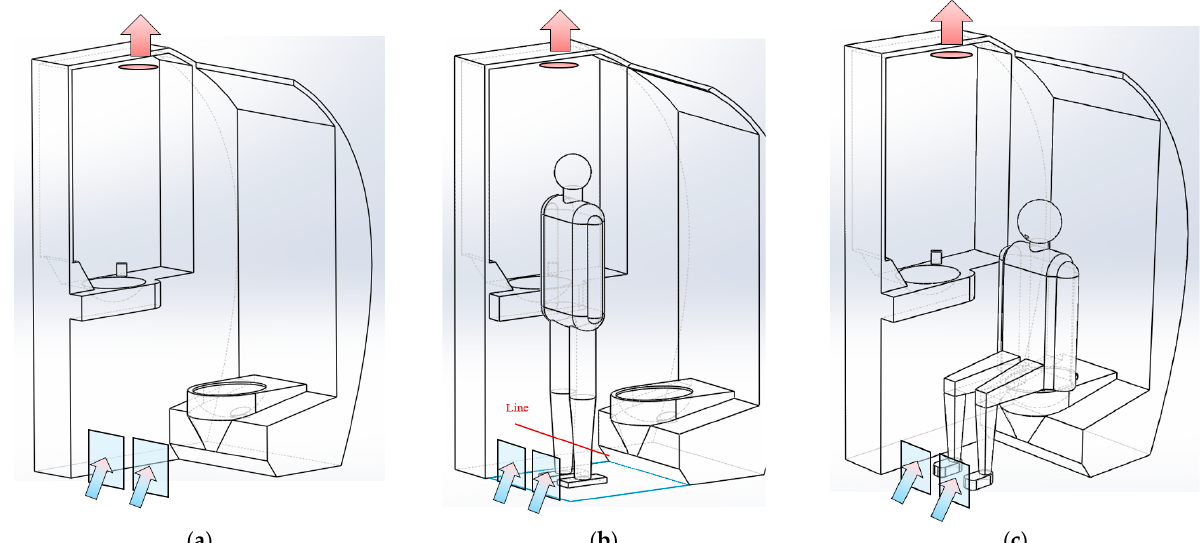
Figure 2. Three investigated scenarios (cases): ( a ) flushing in an empty lavatory; ( b ) a standing manikin flushing; ( c ) a seated manikin coughing.